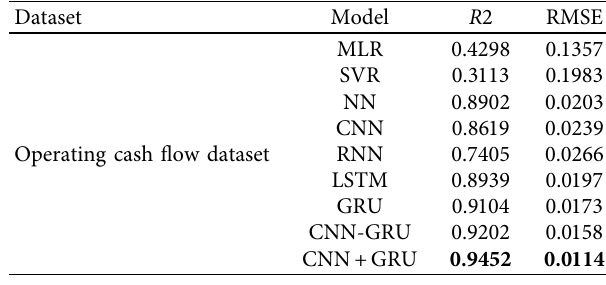
Table 2: Experimental results of forecasting operating cash flow.